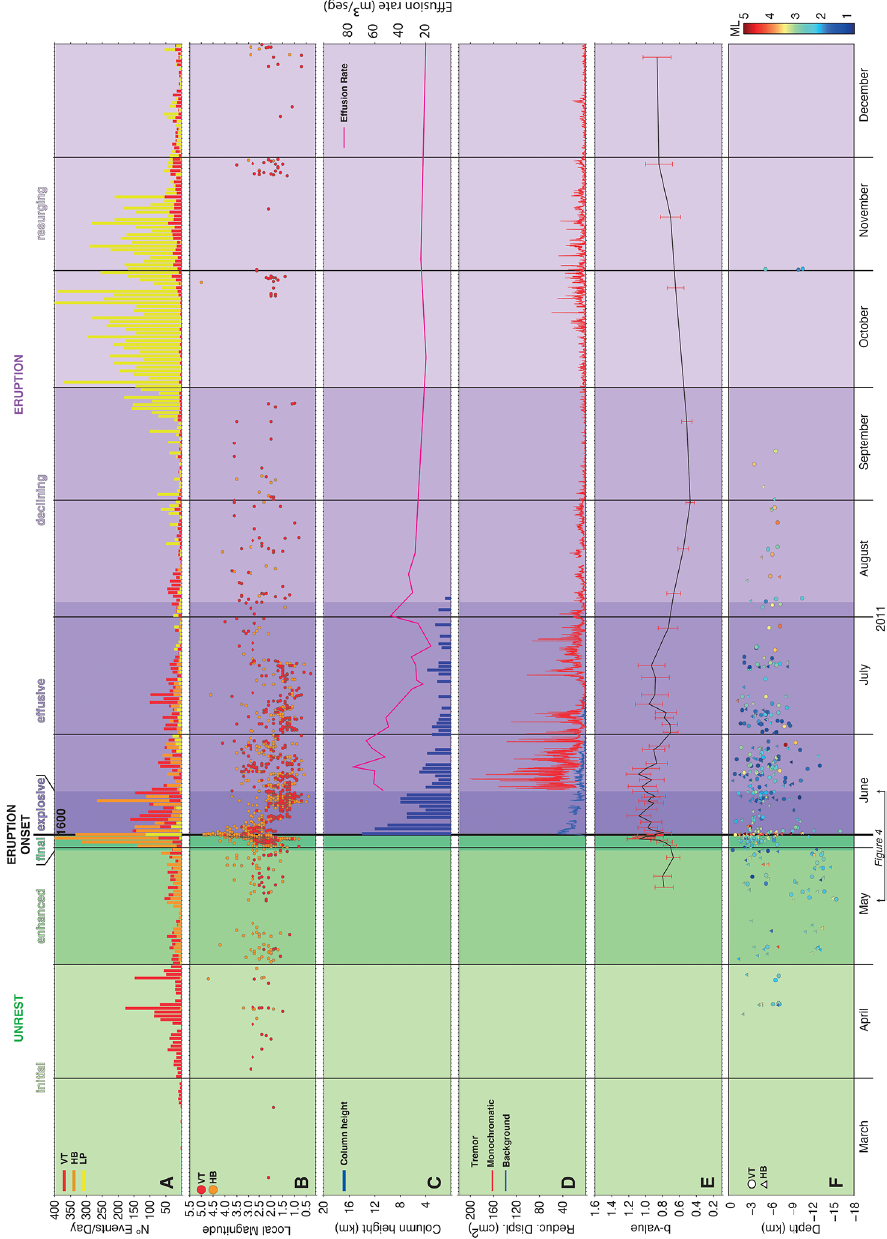
Figure 3. Time series of relevant parameters before (March) and after (December) the 2011 PCCVC eruption (4 June). (a) Daily count of VT (red), HB (orange) and LP (yellow) seismic events recorded at station PHU (see Fig. 1). (b) Local magnitudes from 1750 well-located VT (red) and HB (orange) earthquakes. (c) Height of the pyroclastic column (blue) and effusion rate (red, after Bertin et al., 2015). (d) Reduced displacement of the background tremor (blue) accompanying the explosive phase and the monochromatic tremor (red) dominating the effusive phase. (e) The b value (grey line) with error bars (red). (f) Hypocenter depths and magnitudes for the best-located 425 VT (circles) and HB (triangles) earthquakes. At the bottom of the figure we mark the time window enlarged in Fig. 4. Color panels and text on top of the figure define the different phases described in the main